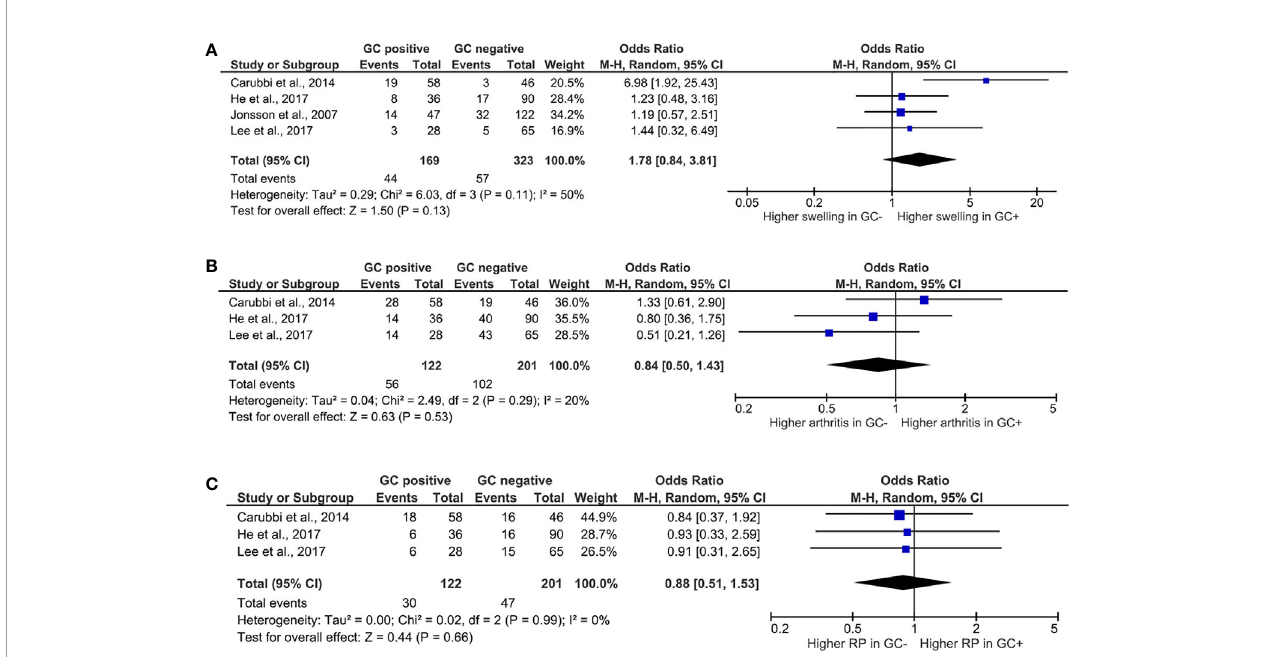
FIGURE 2 | Meta-analysis of the presence of salivary gland swelling (A) , arthritis (B) , and Raynaud ’ s phenomena (C) between patients with Sjögren ’ s syndrome with or without ectopic germinal center. The size of squares is proportional to the weight of each study. Horizontal lines indicate the 95% CI of each study; diamond, the pooled estimate with 95% CI; N, the number of persons at baseline; and OR, odds ratio; GC, germinal center; RP, Raynaud ’ s phenomena.